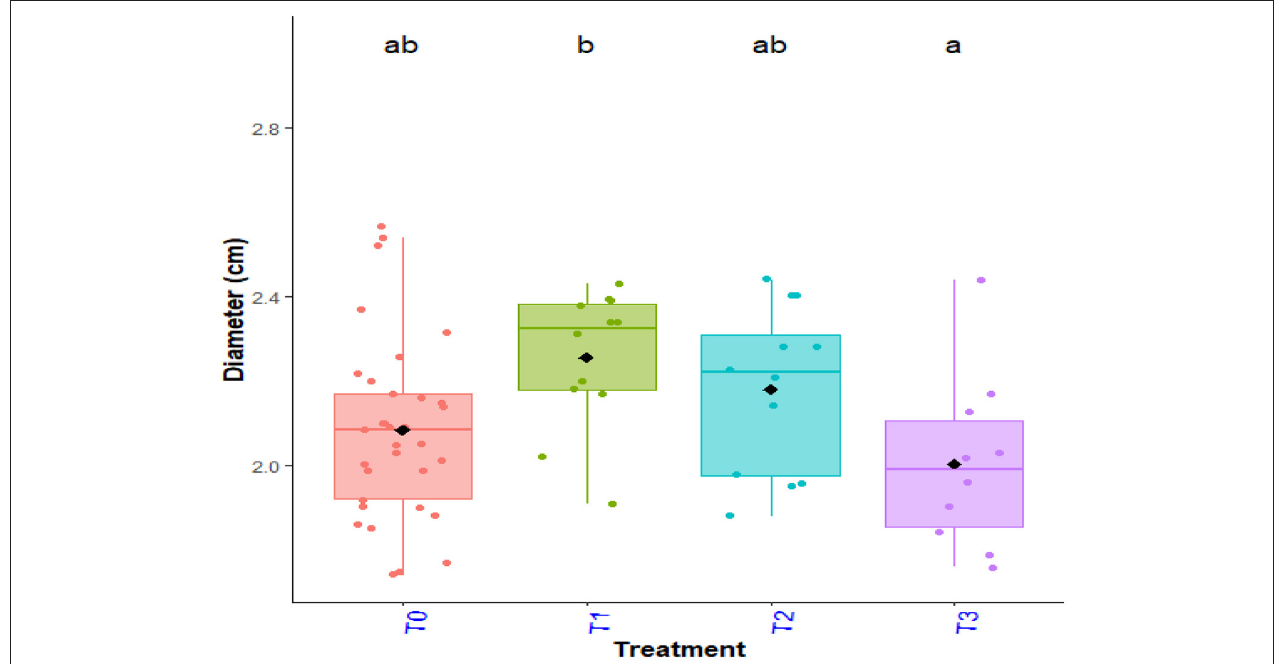
FIGURE 5 | Stem diameter of maize plants as a function of treatments. T 0 :100% NPK + urea; T 1 : clay + P. putida + ½ NPK + Urea, T 2 : peat + P. putida + ½ NPK + Urea, T 3 : clay-peat + P. putida + ½ NPK + Urea.